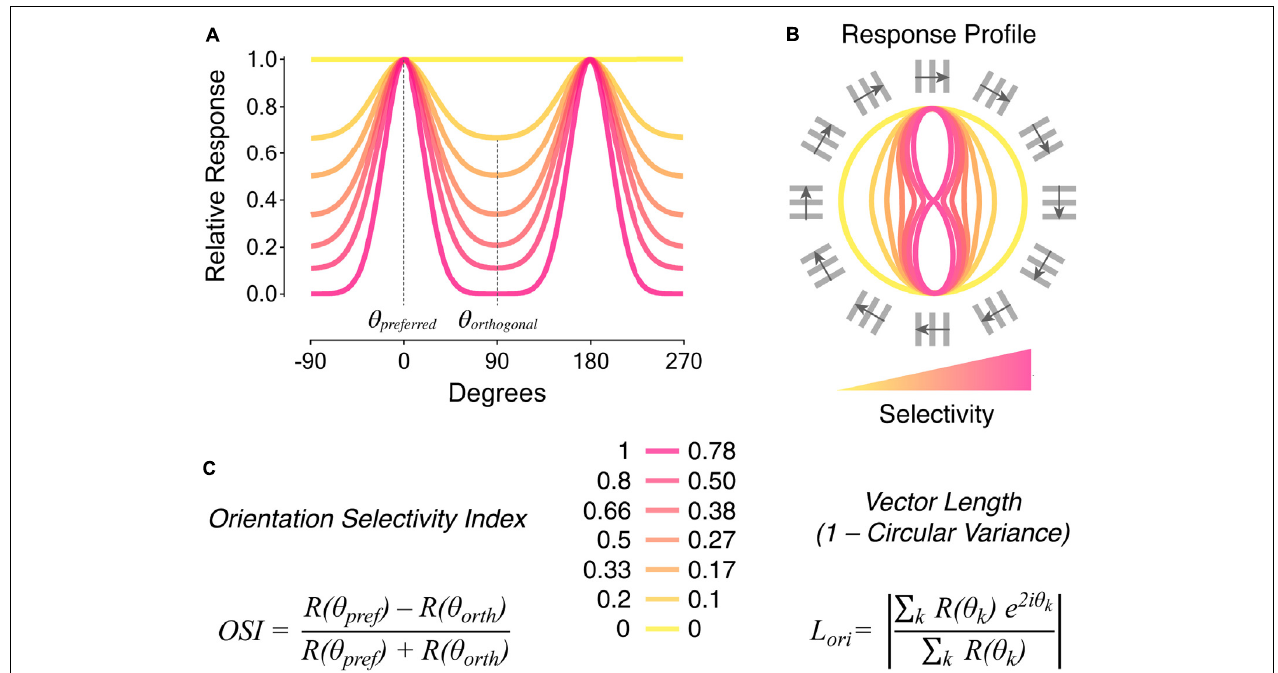
FIGURE 1 | Metrics to quantify orientation selectivity in neural responses. (A) Tuning curves of neural responses to oriented visual stimuli. The color coding indicates different levels of orientation selectivity, from low (yellow) to high (magenta). The preferred orientation angle ( θ preferred ) corresponds to the angle of the stimulus eliciting maximal responses. The orthogonal orientation angle ( θ orthogonal ) corresponds to angles of stimuli oriented ± 90 ◦ relative to the preferred orientation angle. (B) Response profiles to oriented visual stimuli corresponding to the tuning curves represented in (A) . The orientation and direction of movement of square-wave gratings with 30 ◦ angular distance steps are indicated around. (C) Metrics typically used to quantify orientation selectivity in neural responses: orientation selectivity index (OSI; left), and vector length in orientation space ( L ori also known as 1 – circular variance; right). Quantification of orientation selectivity for the responses in (A,B) is reported in the middle. Note that the two metrics have different sensitivities to tuned firing. The OSI consists in the difference between responses to preferred, R( θ pref ) , and orthogonal, R( θ orth ) , stimuli divided by their sum. On the other hand, L ori takes as input responses to all orientation angles, R( θ k ) , in order to calculate the mean vector length in orientation space ( k ranges from 0 ◦ to 180 ◦ ). See Mazurek et al. (2014) for detailed descriptions and comparisons of the two